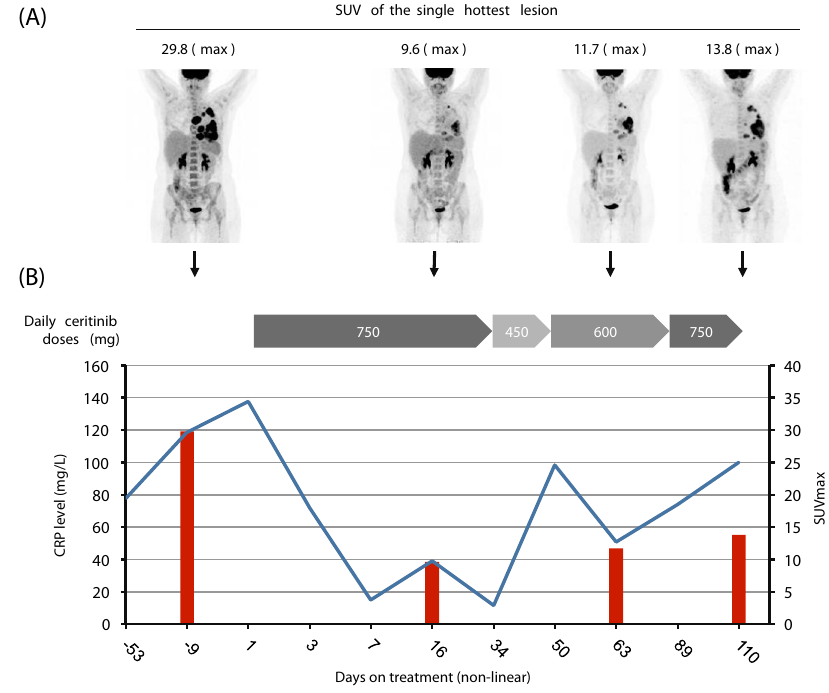
Fig. 2 Metabolic response evaluation and CRP levels. a Baseline 18 FDG-PET/CT and follow-up scans showing metabolic response with decreasing uptake. b Non-linear chart of serum CRP levels (mg/L) ( blue graph ) and change of SUV max in the single hottest lesion ( red columns ). Gray arrows : ceritinib treatment at daily doses indicated (mg); blue graph : CRP levels (mg/L); red columns : SUV max of the hottest